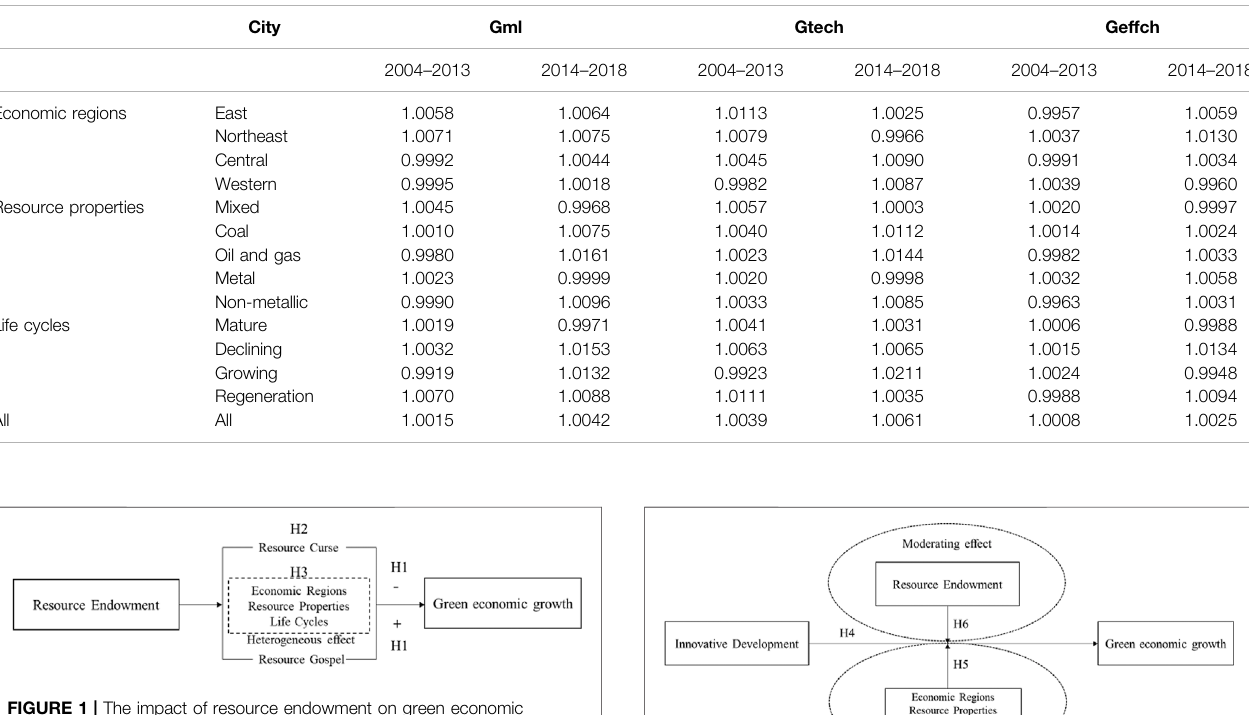
FIGURE 1 | The impact of resource endowment on green economic growth in resource-based cities.